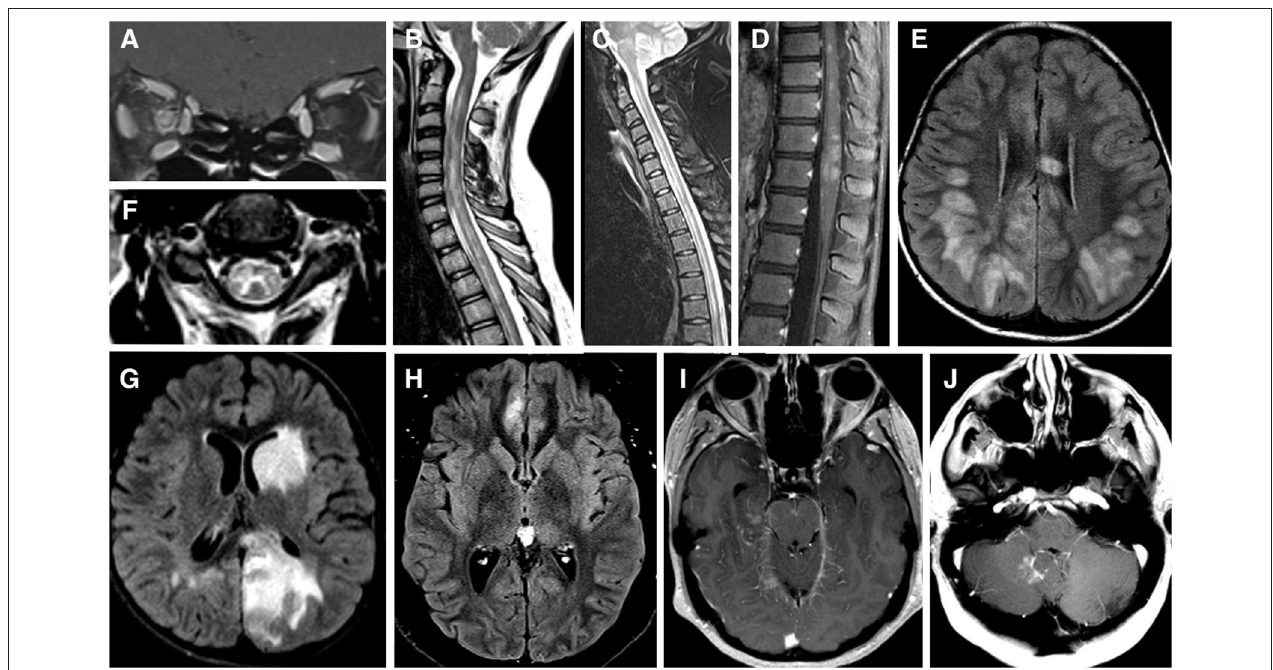
FIGURE 1 | (A) MRI brain T1 coronal post gadolinium contrast showing contrast enhancement of bilateral optic nerves and right optic nerve sheath consistent with perioptic neuritis. (B) MRI spine sagittal STIR showing longitudinal extensive patchy lesion spaning from cervical to thoracic cord. (C) MRI spine sagittal T2 showing hyperintense longitudinally extensive “pseudo-dilation” of central canal. (D) MRI spine sagittal T1 post gadolinium contrast showing patchy enhancement of the conus medullaris. (E) MRI brain axial FLAIR showing large subcortical and septal white matter lesions in a pediatric patient presenting with ADEM. (F) MRI brain axial T2 with hyperintense “H” sign outlining the central gray matter of the upper cervical cord in a teenager with myelitis. (G) MRI brain axial T2 with “fluffy” hyperintense lesion of gray and white matter of the left caudate and left occipital parietal regions in a pediatric patient who presenting with ADEM. (H) MRI brain axial T2 showing unilateral FLAIR hyperintensity and edema of right mesial frontal cortex in a patient with FLAMES syndrome. (I) MRI brain axial T1 post gadolinium contrast showing leptomeningeal enhancement of the midrain and right mesial temporal lobe. (J) MRI brain axial T1 post gadolinium contrast showing a lesion adjacent to the cerebellar vermis and dorsal medulla in a patient with brainstem syndrome and no other